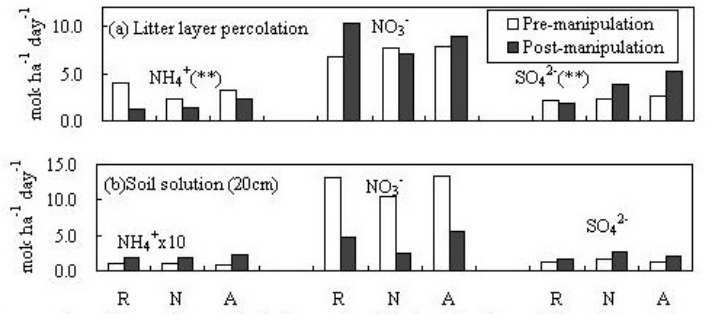
FIGURE 5. The effects of N manipulation to the daily ion flux from (a) litter layer and (b) soil solution (20-cm depth) in Yasato. Confidende limit: 99% (**), 90% (*), R: removal, N: no manipulation, A: addition